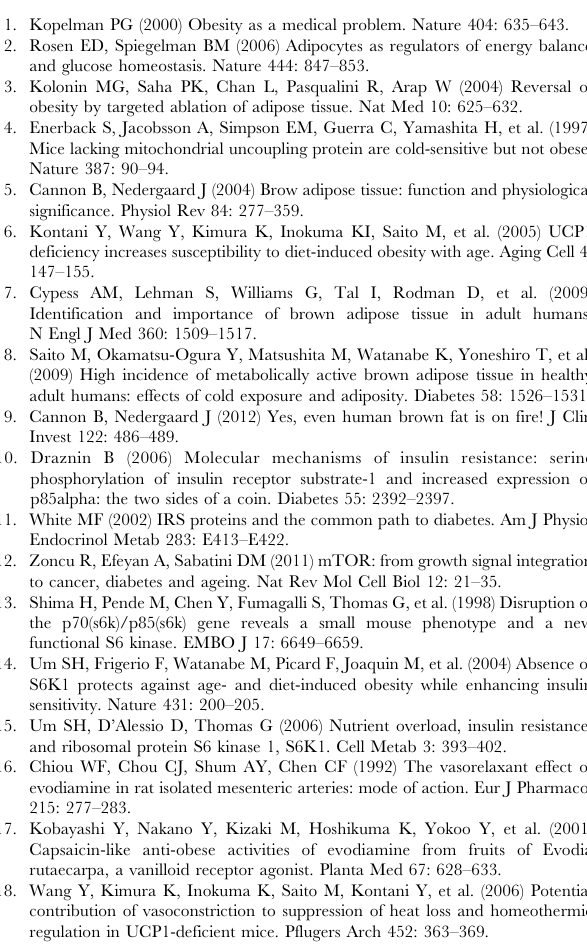
Data are expressed as mean 6 SEM ( n = 5). * p , 0.05 vs. vehicle group. Figure S2, Effect of evodiamine on phosphorylation of mTOR, Akt and IRS1 in the WAT of obese UCP1-KO mice. Western blot analysis for mTOR (A), Akt (B) and IRS1 (C) was done with tissue lysates (50 m g protein) of epididymal WAT from the UCP1-KO mice fed a high-fat diet with or without evodiamine for 2 months as described in Supplemental Methods. Phosphor- ylation levels of mTOR Ser2448, Akt Ser473 and IRS1 Ser636/ 639 were normalized to the total level of each protein. Data are expressed as mean 6 SEM ( n = 4). * p , 0.05 vs. control group. Figure S3, Effect of evodiamine on phosphorylation of mTOR and UCP1 in the BAT of KK-Ay mice treated with evodiamine. Western blot analysis for mTOR (A) and UCP1 (B) was done with tissue lysates (30 m g protein) of BAT from KK-Ay mice treated with evodiamine for 7 days. Levels of mTOR Ser2448 phosphorylation and UCP1 protein were normalized to the total mTOR and tubulin levels, respectively. Data are expressed as mean 6 SEM ( n = 5). Figure S4, Effect of evodiamine on phos- phorylation of mTOR, S6K, Akt and IRS1 in the gastrocnemius muscle (GM) of KK-Ay mice treated with evodiamine. Western blot analysis for mTOR (A), S6K (B), Akt (C) and IRS1 (D) was done with tissue lysates (30 m g protein) of GM from KK-Ay mice treated with evodiamine for 7 days. Phosphorylation levels of mTOR Ser2448, S6K Thr389, Akt Ser473 and IRS1 Ser636/639 were normalized to the total level of each protein. Data are expressed as mean 6 SEM ( n = 5). Figure S5, Effect of evodiamine